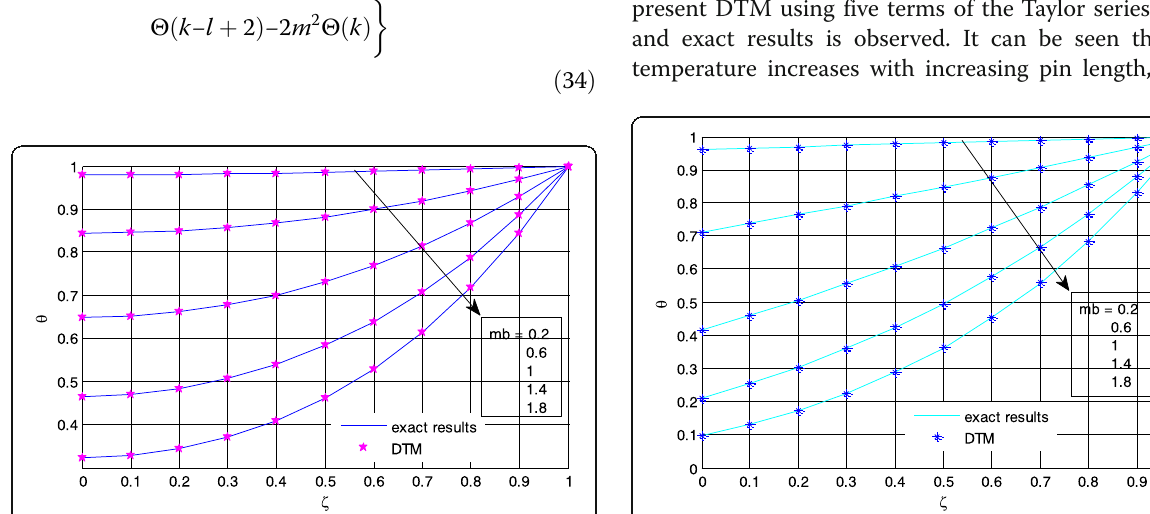
Fig. 8 Temperature evolution for a conical